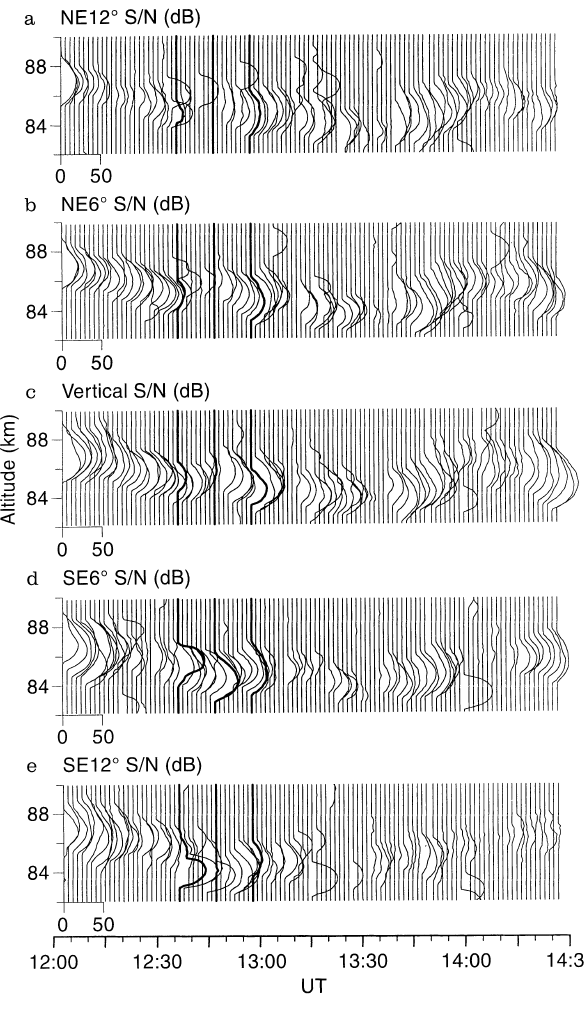
Fig. 3a–e. Altitude profiles of S/N for a NE12 (cid:14) , b NE6 (cid:14) , c vertical, d SE6 (cid:14) and e SE12 (cid:14) beams on 15 May 1992. Attention is drawn to the vertical motions observed in the time-periods 12:36–12:48 UT and 12:48–12:58 UT bounded by the bold profiles